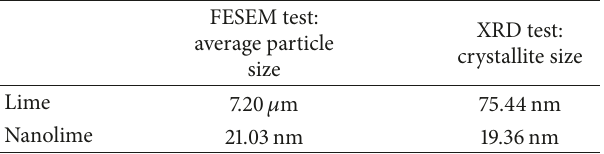
Table 7: Average particle size and crystallite size of lime and nanolime.